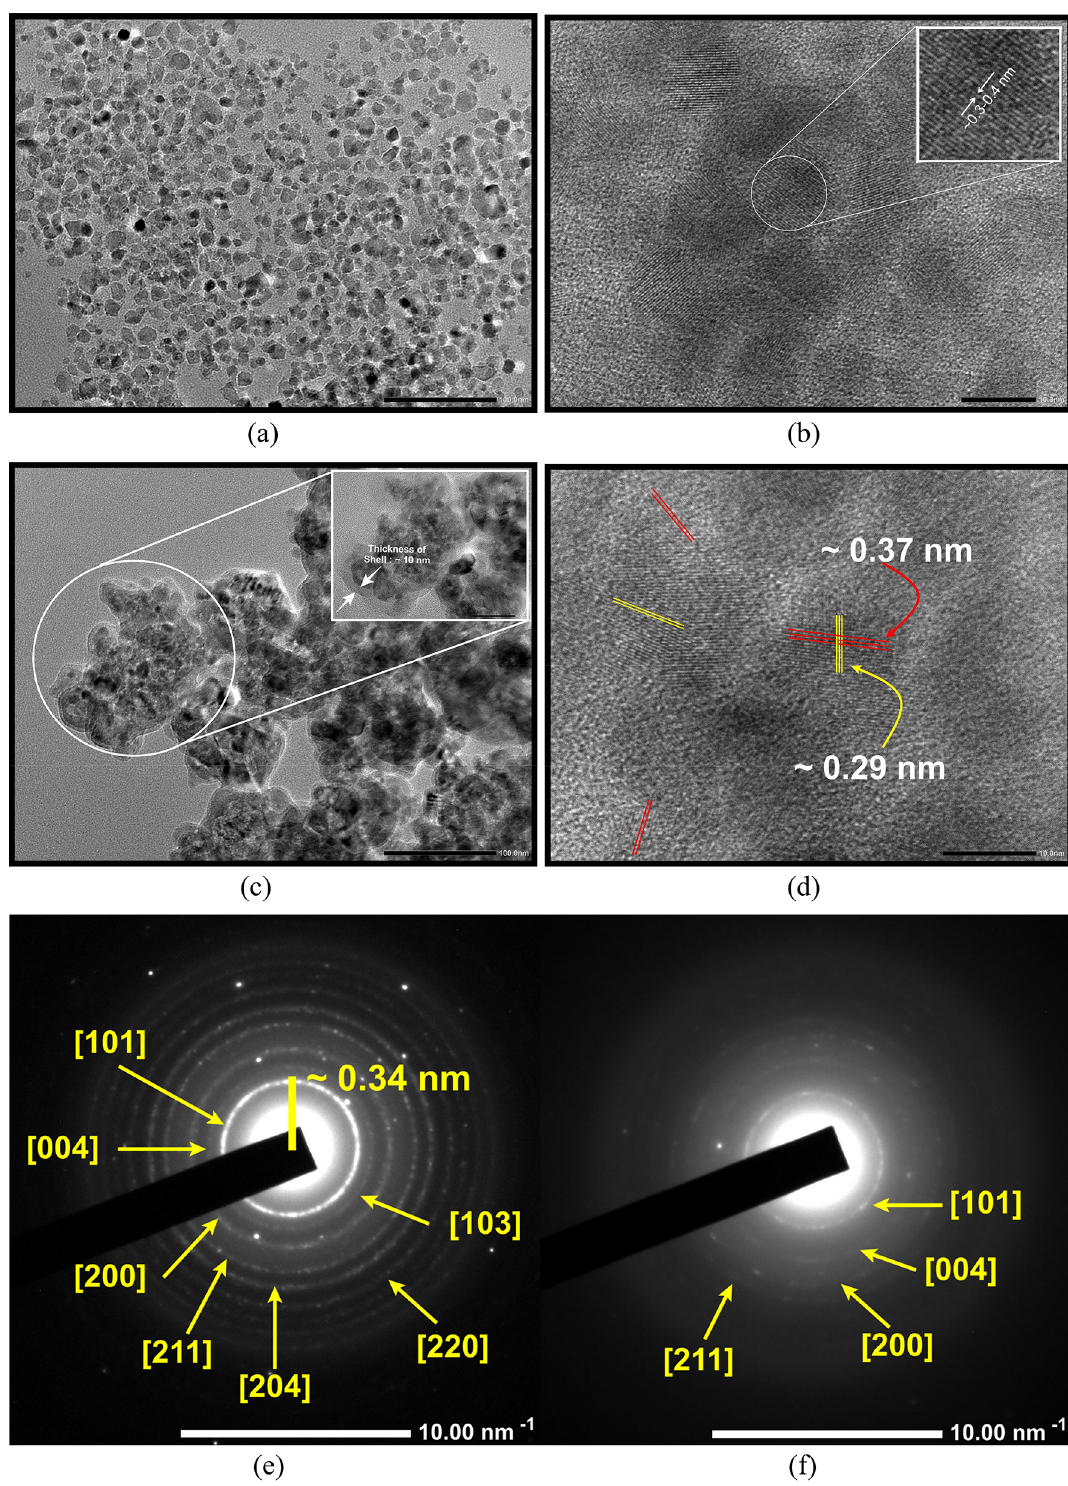
Figure 3. ( a , b ) HR-TEM images of TiO 2 NPs, ( c , d ) HR-TEM images of Fe@TiO 2 NPs, ( e ) SAED pattern of TiO 2 NPs and ( f ) SAED pattern of Fe@TiO 2